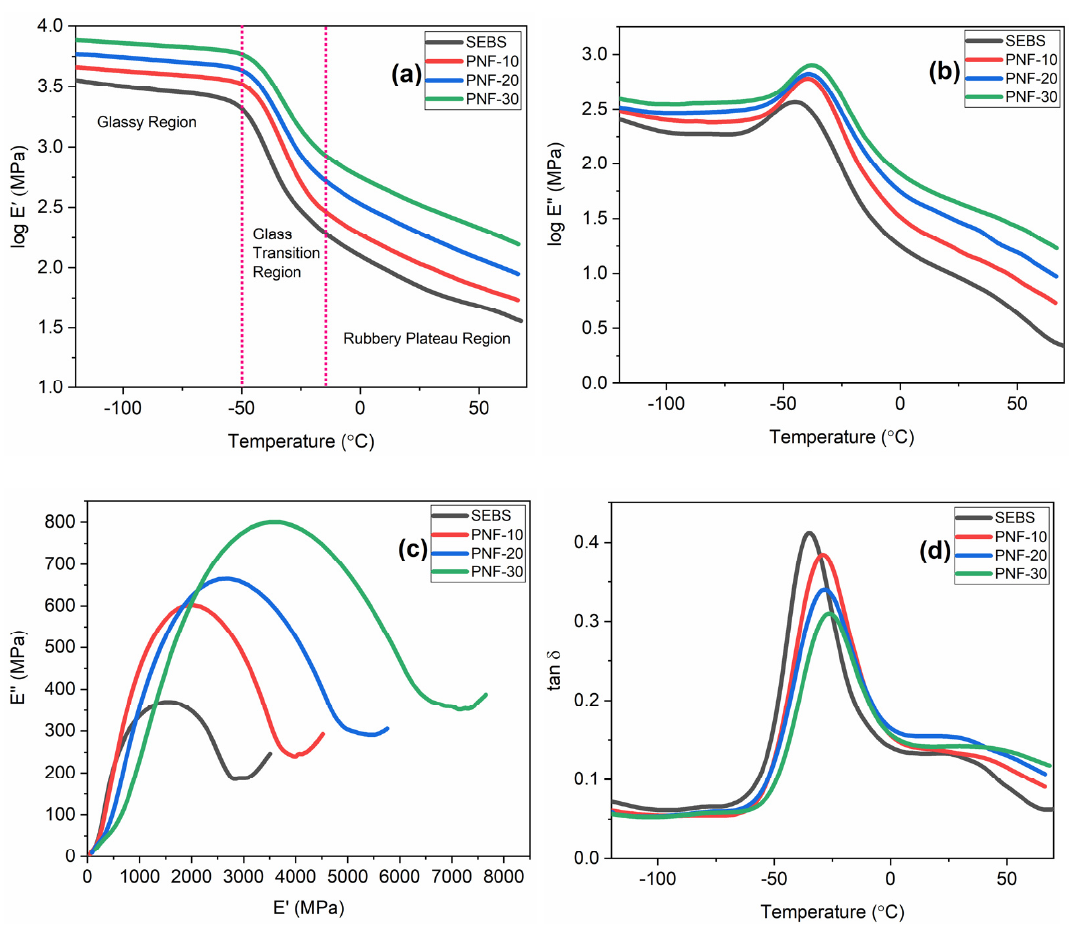
Figure 7. ( a ) Storage modulus, ( b ) loss modulus, ( c ) Cole–Cole plots, and ( d ) tan δ plots of the com-